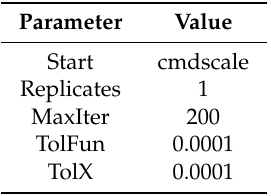
Table 3. Parameters of the multidimensional